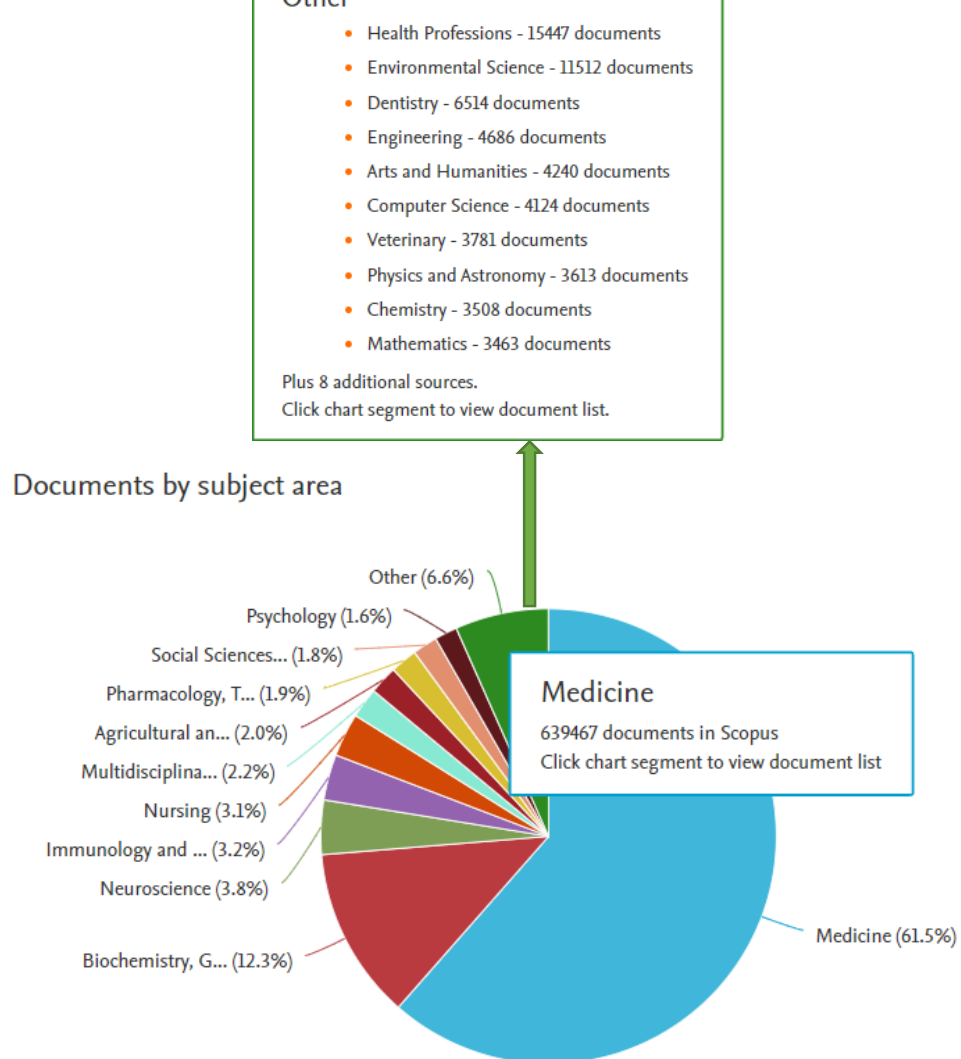
Figure 2. The search results for TITLE-ABS-KEY (cohort AND analysis) query by subject area in